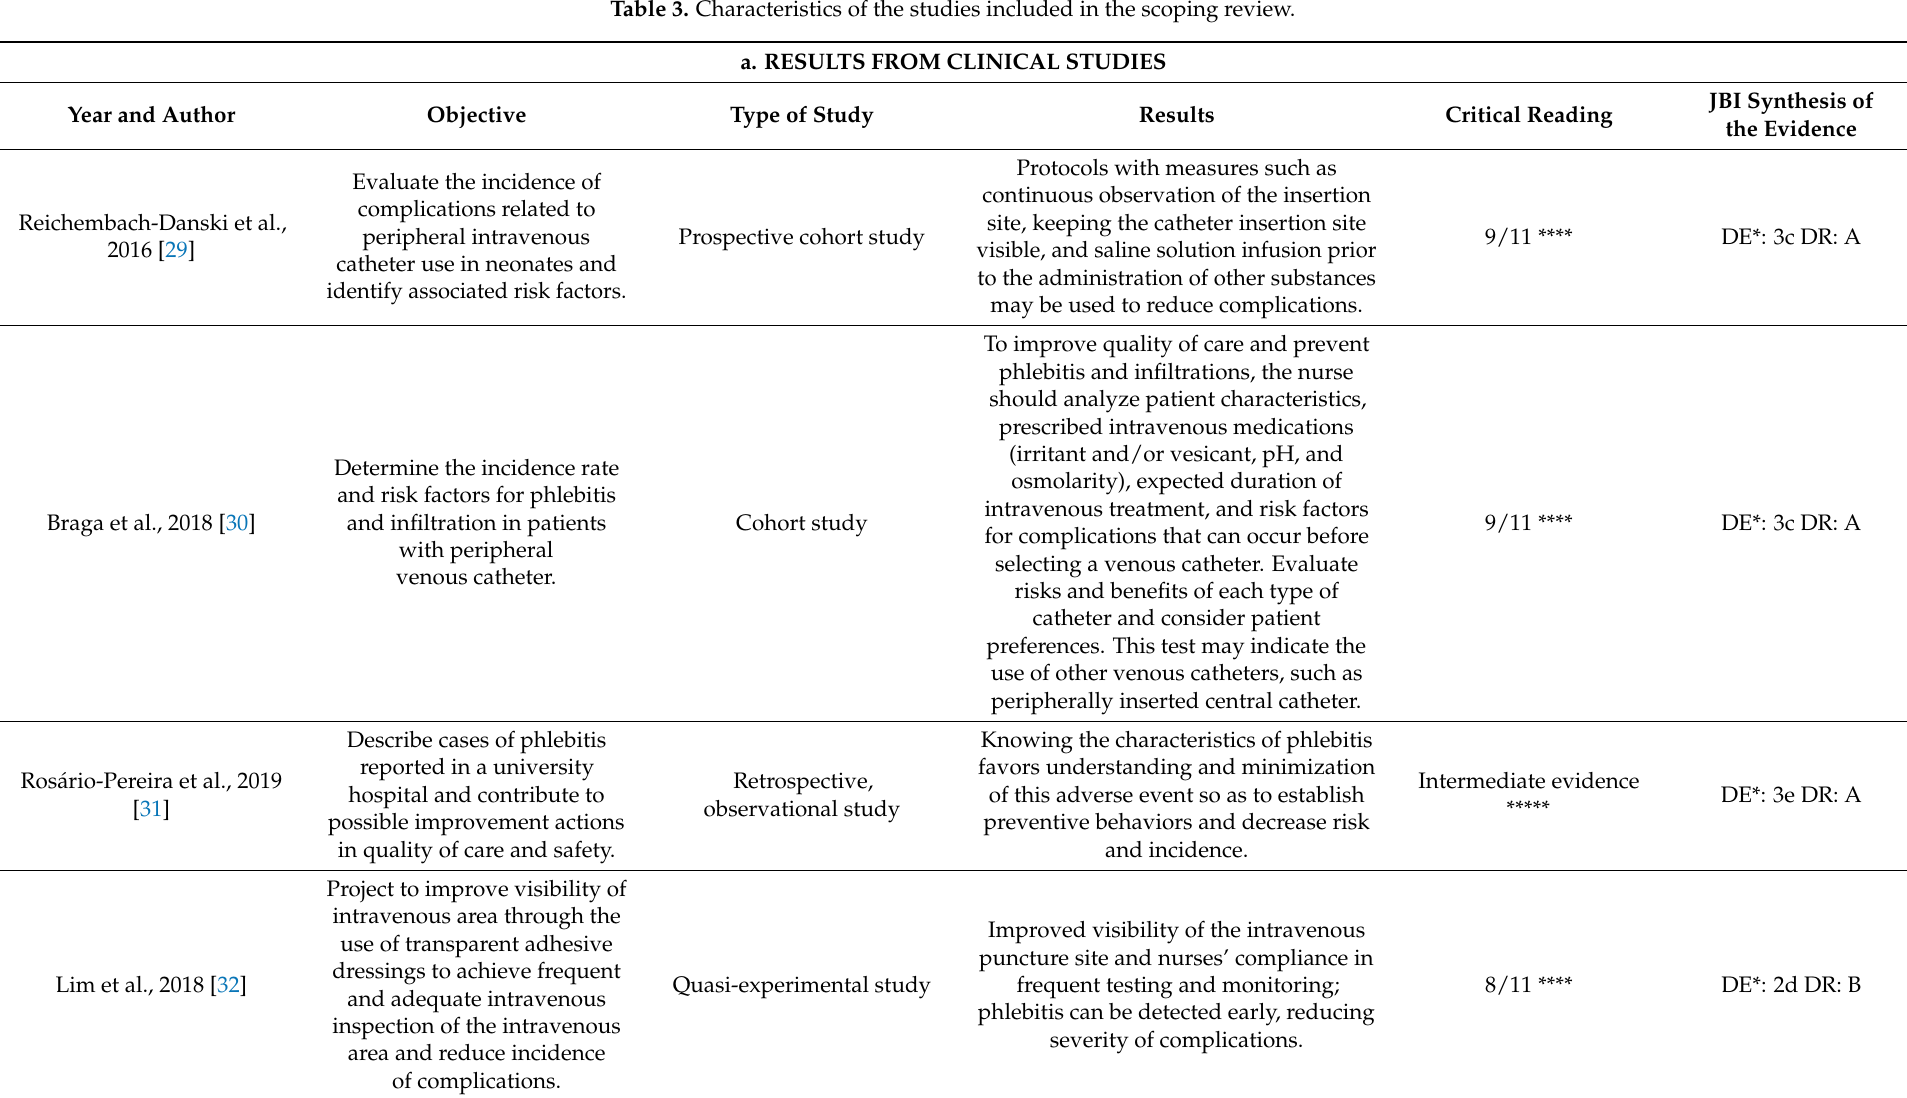
Table 3. Characteristics of the studies included in the scoping